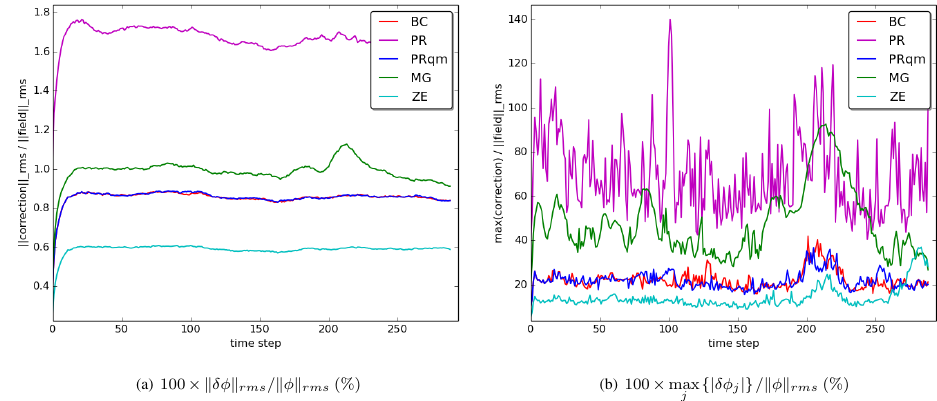
Fig. 5. 48 hrs timeseries of global rms-norms (left) and max-norms (right) of MFAs increments for CLWC Figure 5. 48h time series of global rms norms (a) and max norms (b) of MFA increments for CLWC expressed as a percentage of the rms expressed as a percentage of the rms-norm of the field. norm of the